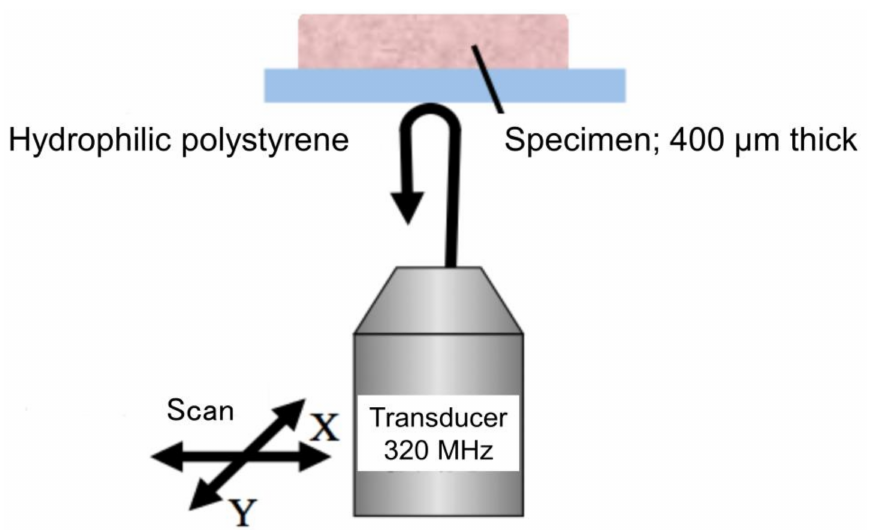
Figure 1. Scanning acoustic microscope. The ultrasound emitted by an acoustic transducer hits or penetrates the tissue and is reflected the surface of the tissue or the hydrophilic polystyrene. It is then returned to the